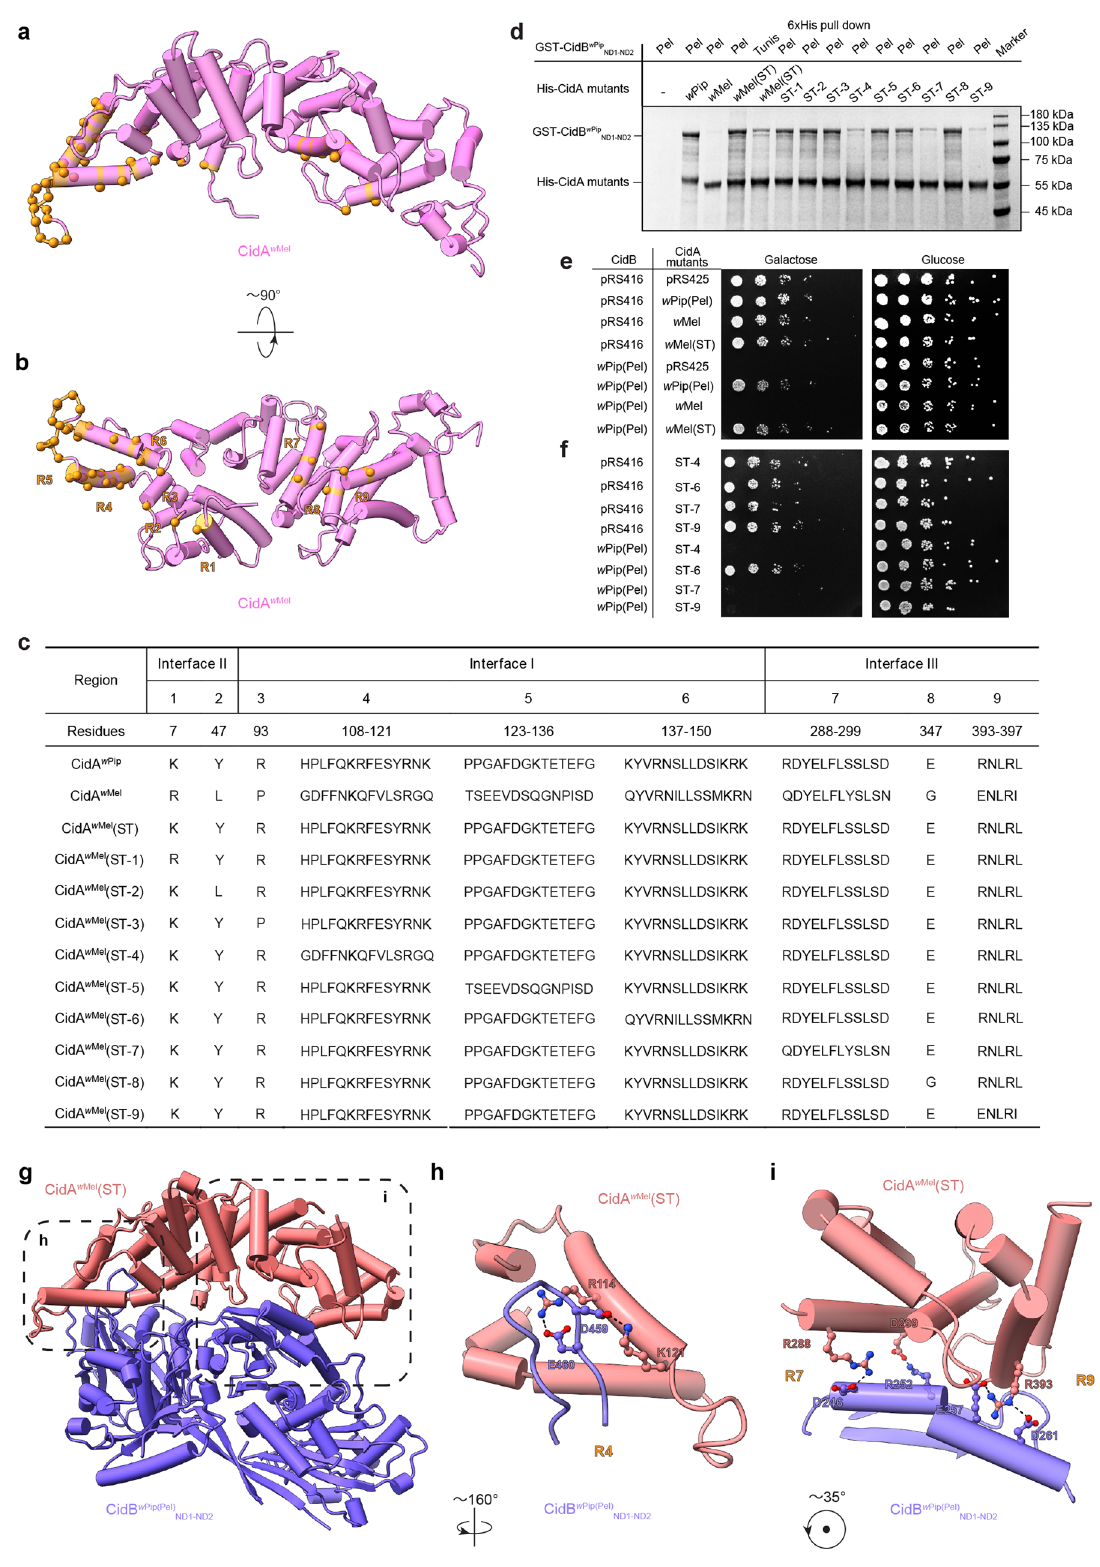
(Fig. 3c). These residues are not charged and may lead to the reduced binding of CidA w Mel (ST-4) to CidB w Pip(Pel) ND1-ND2 (Fig. 3d). Similarly, at region 7, residues R288 and D299 of CidA w Mel (ST) have charge complementarity with D246 and R252 of CidB w Pip(Pel) ND1-ND2 , respectively (Fig. 3i). In the CidA w- Mel (ST-7) revertant, residues 288 and 299 are glutamine and